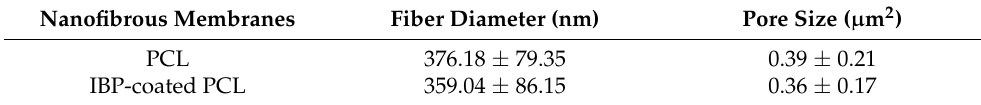
Table 1. Physical properties of PCL and IBP-coated PCL membranes (n = 120).